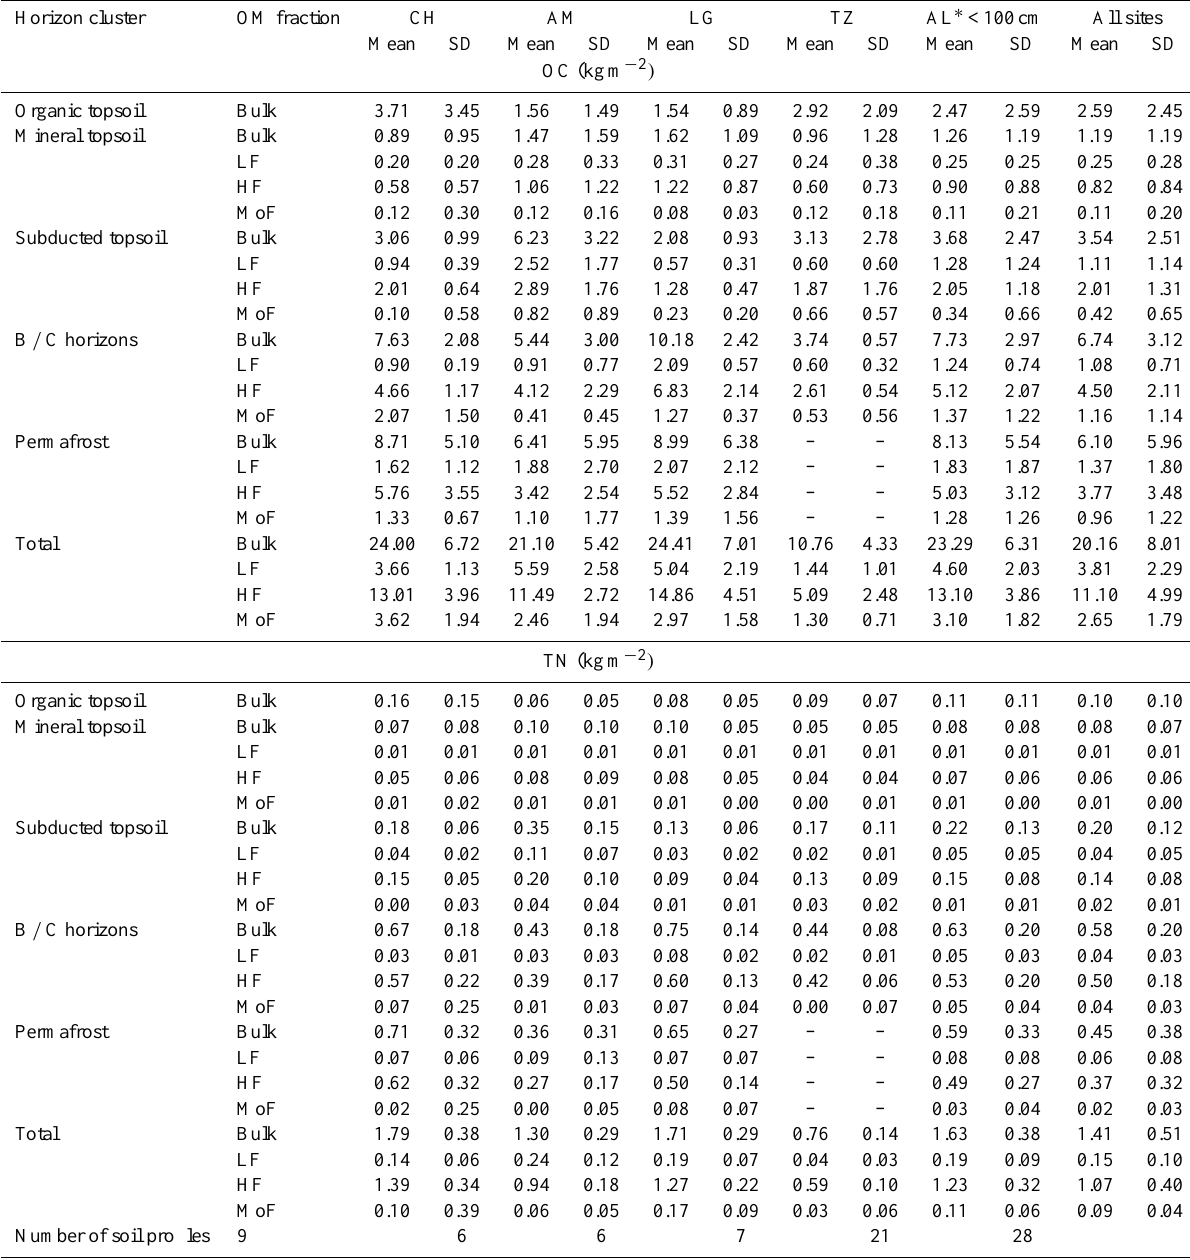
Table 2. Mean soil OC and TN stocks (0–100cm) with respect to different sampling sites and soil horizons plus standard deviation (SD). Bulk values (unfractionated stocks) were separated into light fraction (LF), heavy fraction (HF), and the mobilized fraction (MoF). The total bulk values include the organic